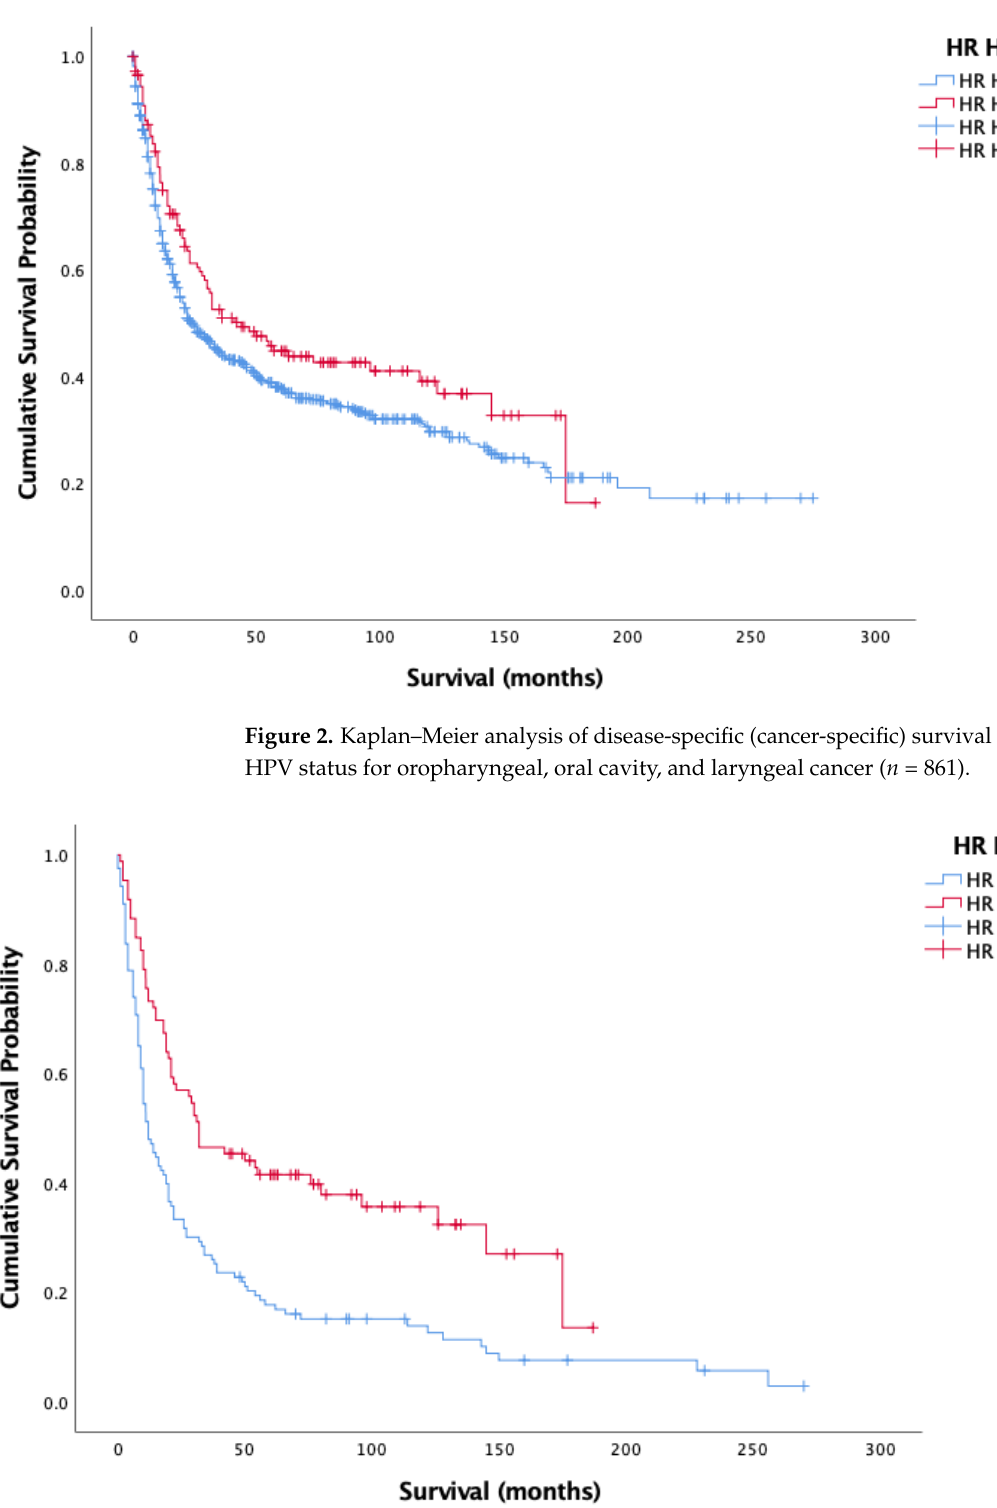
Figure 3. Kaplan – Meier analysis of overall survival in months based on HR HPV status for oropha- ryngeal cancer (n = 209).